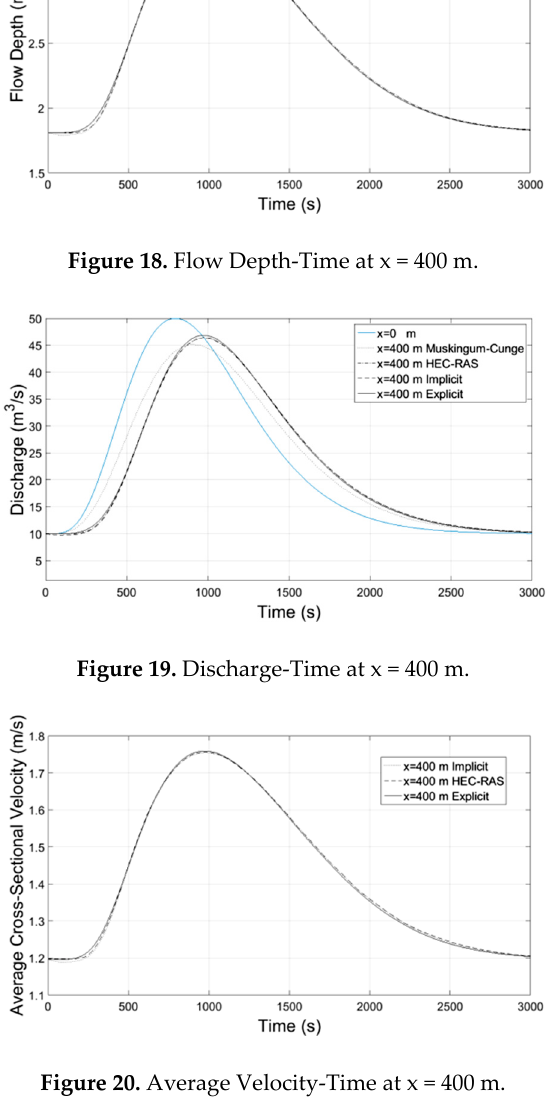
Figure 20. Average Velocity-Time at x = 400